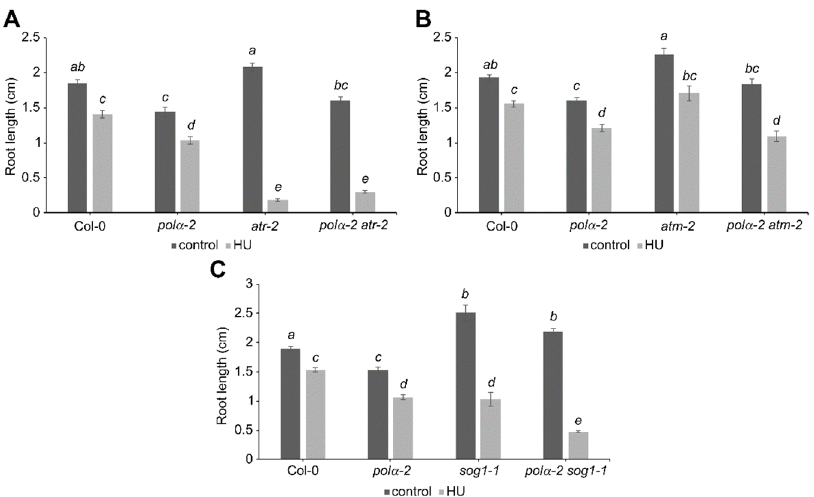
Figure 5. The pol α -2 mutation does not confer tolerance to replication stress in other DDR regulator mutant lines. Quantification of root growth of 7-day-old ( A ) wild-type (Col-0), pol α -2 , atr-2 , and pol α -2 atr-2 seedlings, ( B ) wild-type (Col-0), pol α -2 , atm-2 , and pol α -2 atm-2 seedlings, or ( C ) wild-type (Col- 0), pol α -2 , sog1-1 , and pol α -2 sog1-1 seedlings grown on control medium or medium supplemented with 0.75 mM HU. Data represent the mean ± SEM ( n > 8). Significance was tested with mixed model analysis. The means with different letters are significantly different ( p <